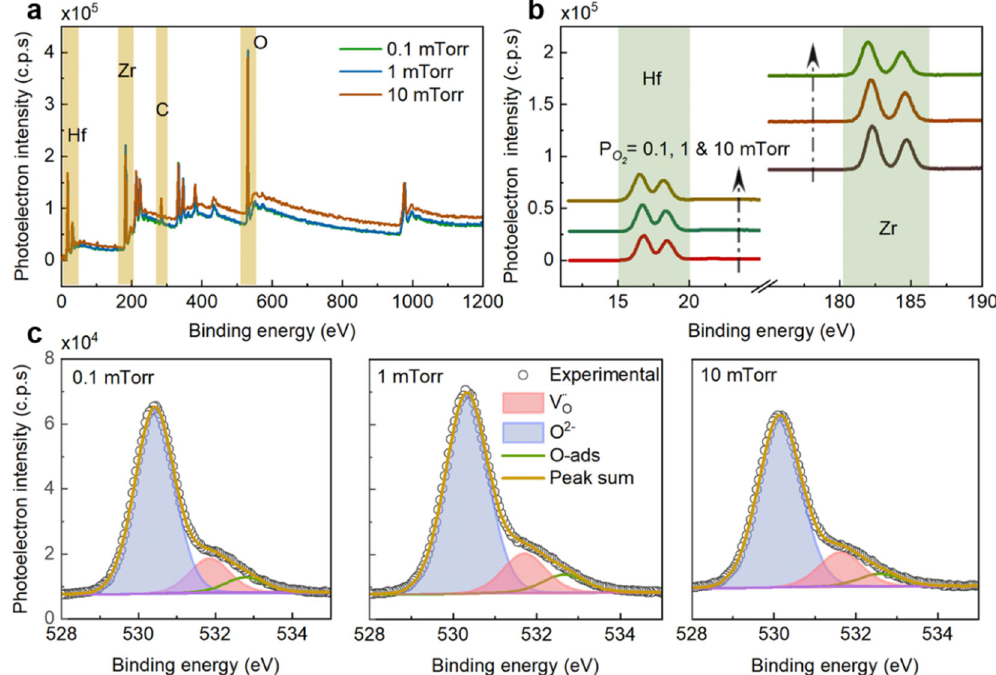
Fig. 3 Surface chemical composition of PLD -HZO thin fi lms by XPS. a Survey spectra of HZO thin fi lms grown with different working P